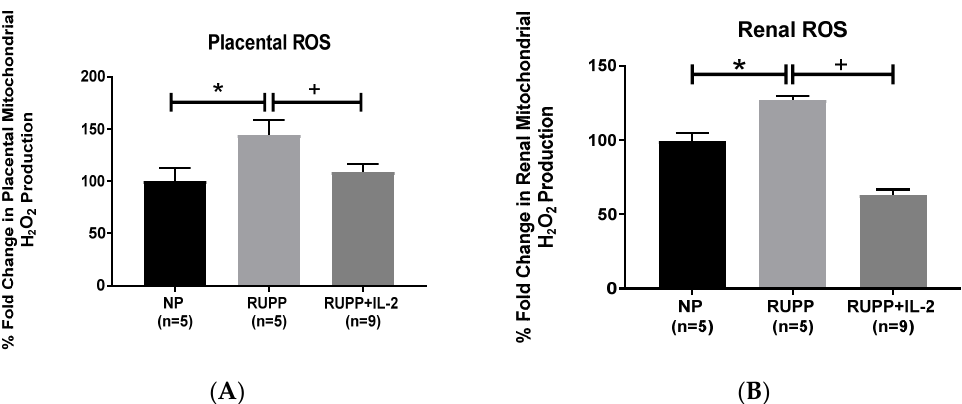
Figure 2. There were increases in the ( A ) placental and ( B ) renal production of mitochondrial ROS in RUPP rats ( n = 5) compared to NP rats ( n = 5). Administration of a low dose IL-2 in RUPP rats ( n = 9) normalized the production of mitochondrial ROS in the placenta and kidney. Results were reported as means ± SEM and considered statistically significant when p < 0.05. (* p < 0.05 vs. NP control; + p < 0.05 vs. RUPP).